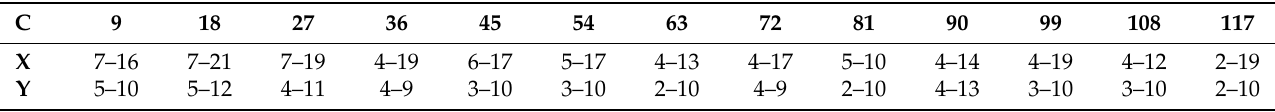
Table 14. Machine efforts were recorded for roughing with the cutting tool according to the number of cycles per part.